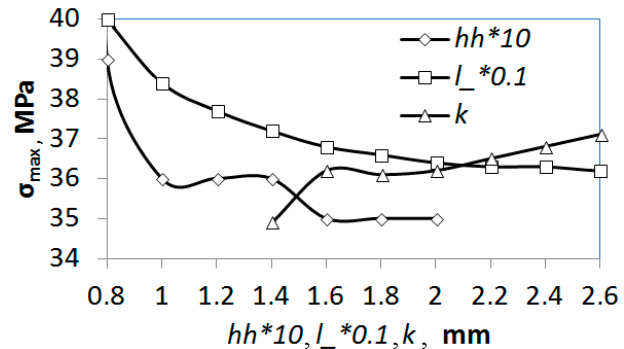
Figure 5. Dependences of the maximum equivalent stresses σ max in the connection on radial clearance in the thread ( hh ), thread length ( l_ ), and pitch ( k ).